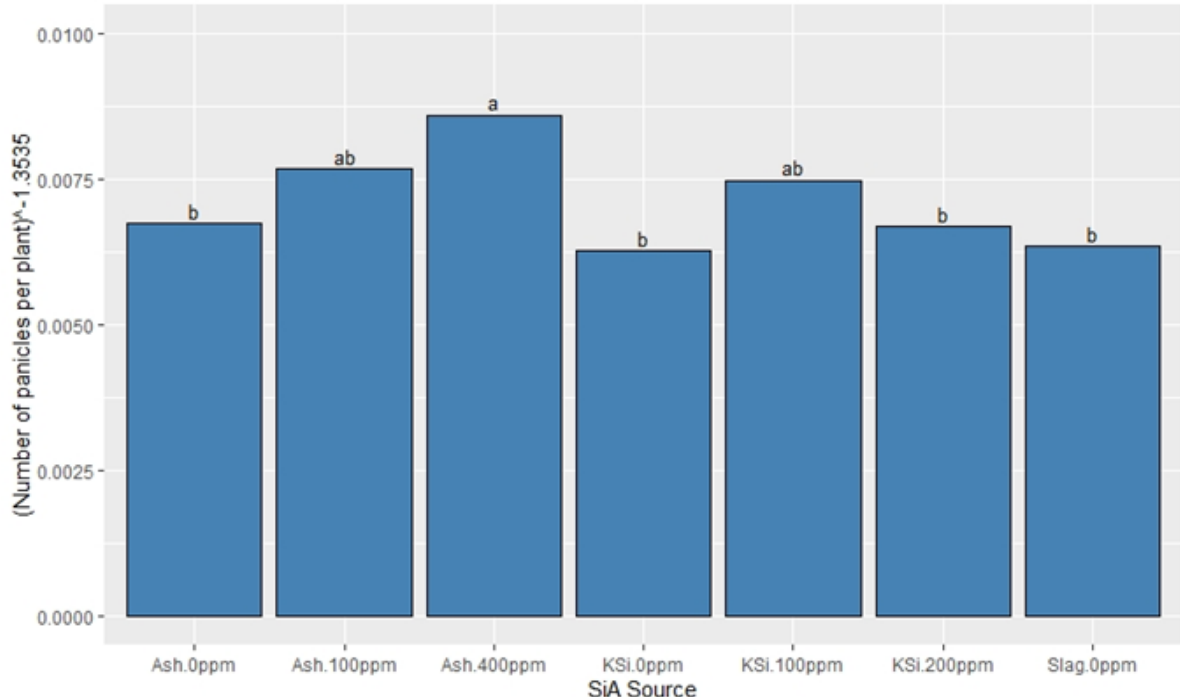
Figure 8 . Statistical summary of ( Number of panicles per plant) -1.3535 . Significance levels were obtained with Tukey test, α = 0.05. Ash stands for rice husk ash; KSi, for potassium silicate and Slag, for ladle furnace